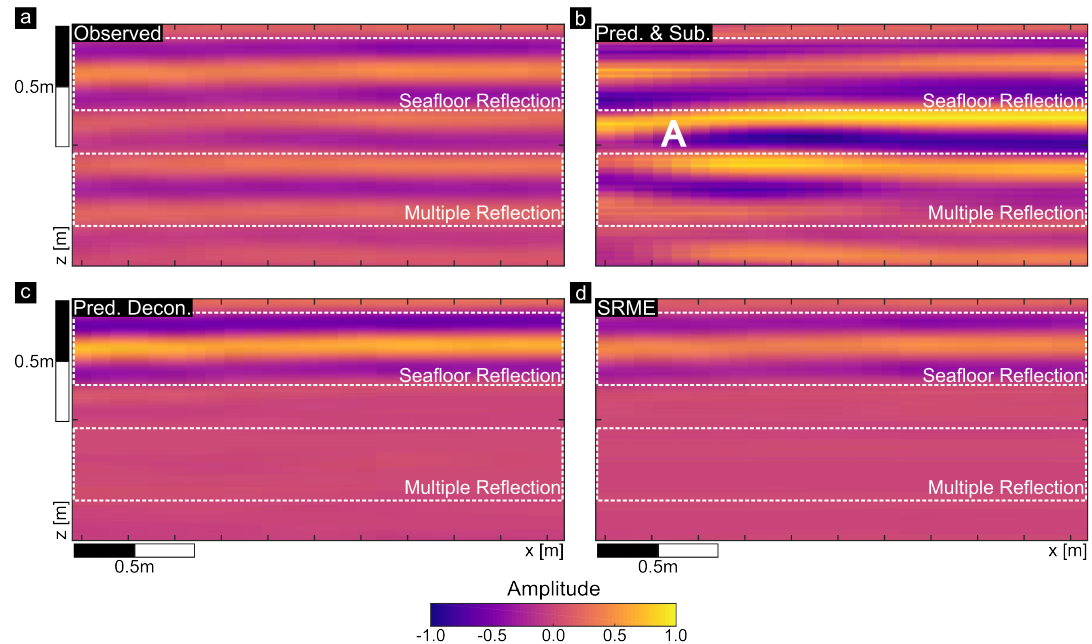
Figure A3. Detail 2 of multi-offset section of field data set 1 from Puck, Poland. The original data ( a ) and results of three multiple attenuation approaches are shown ( b – d ). The seafloor reflection and the first water-layer multiple are highlighted with white boxes. The enhanced reflector of method A is marked by a white A in panel ( b